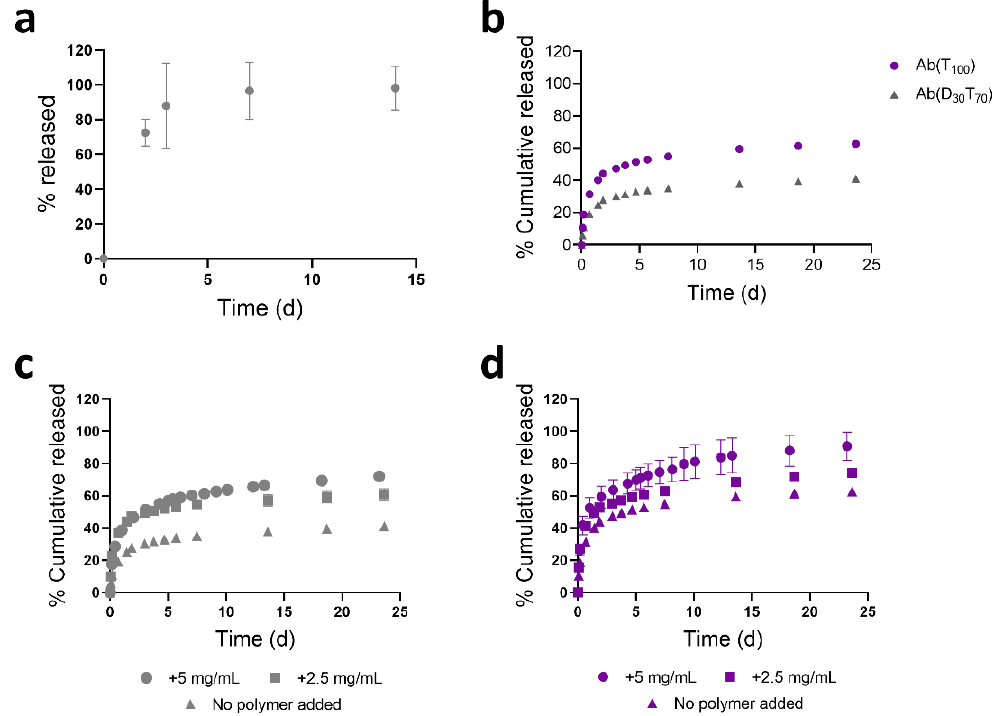
Figure 5. Controlled release of Ab(D x T y ) release from pCB hydrogels influenced by the type of thermoresponsive polymers. ( a ) Release of the Ab(D 30 T 70 ) at 4 ◦ C demonstrating that complete release occurs within ~3 days if the conjugate is completely solubilized. ( b ) Release curves for Ab(D 30 T 70 ) and Ab(T 100 ) at 37 ◦ C demonstrating that P(D 30 T 70 ) lower LCST results in slower release. Release of ( c ) Ab(D 30 T 70 ) and ( d ) Ab(T 100 ) at 37 ◦ C in the presence of 2.5 and 5 mgmL − 1 of free P(D 30 T 70 ) or P(T 100 ), respectively, demonstrating that release is due to conjugate phase transitions ( n = 3, ± standard devia- tion).